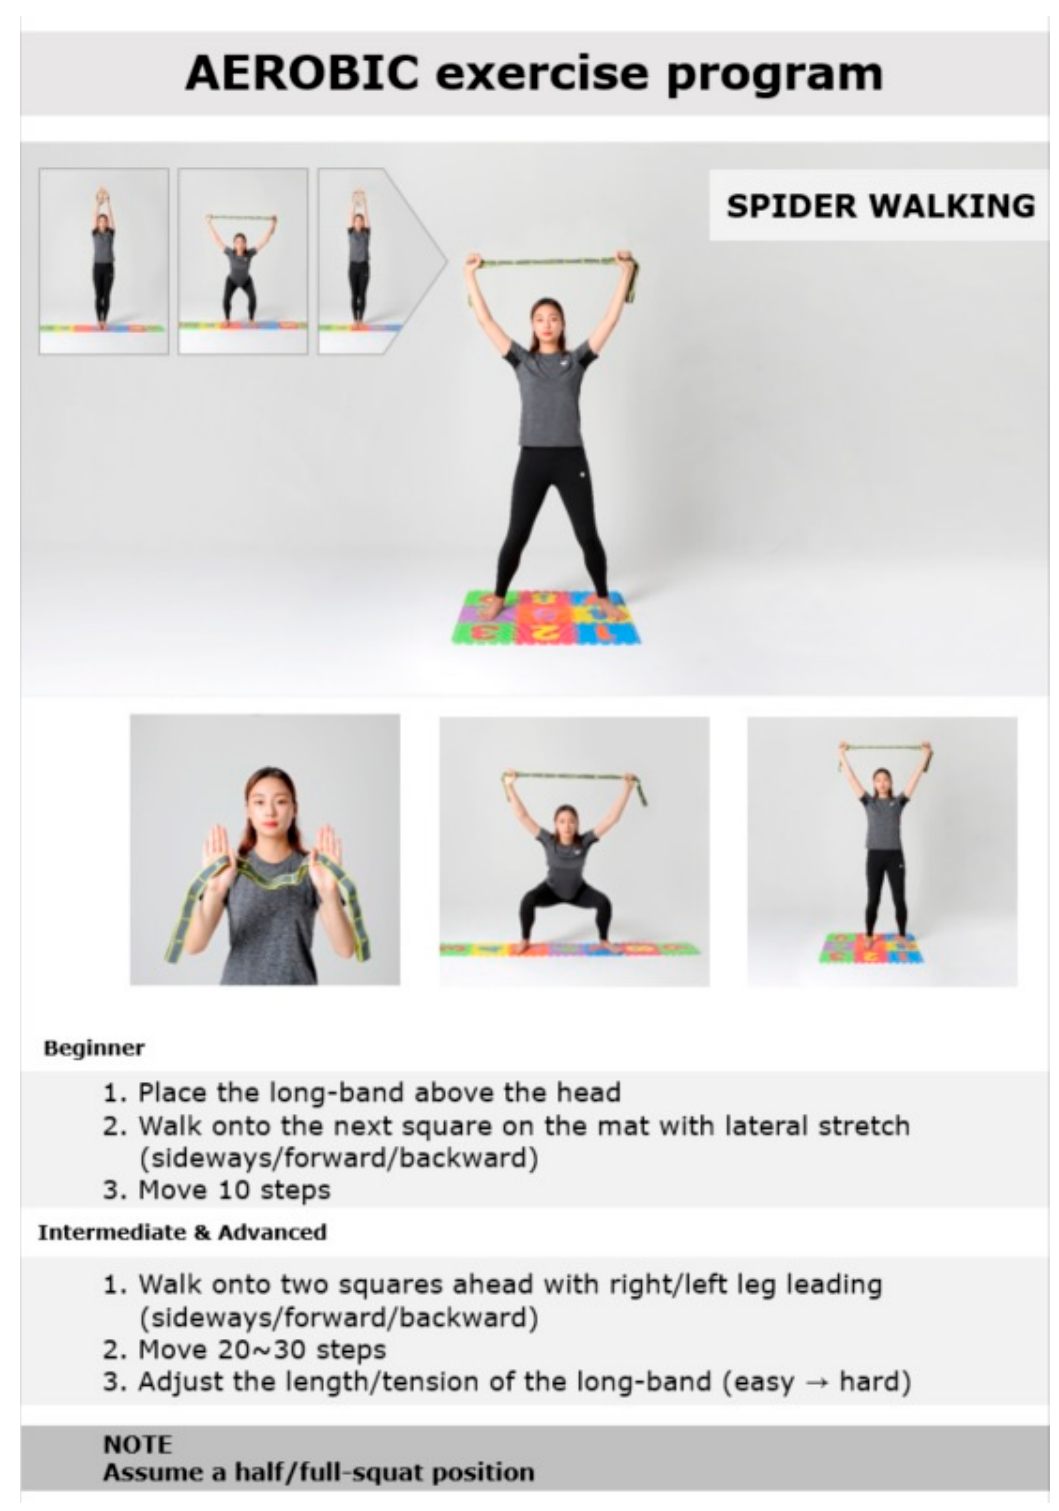
Figure A10. Detailed description and components of each movement in the “Spider walking” aerobic exercise.